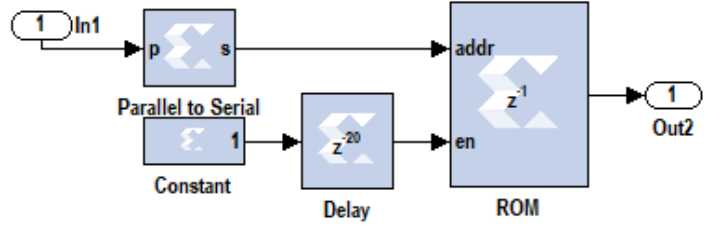
Fig. 6. Xilinx SG block diagram of Mapping Block.